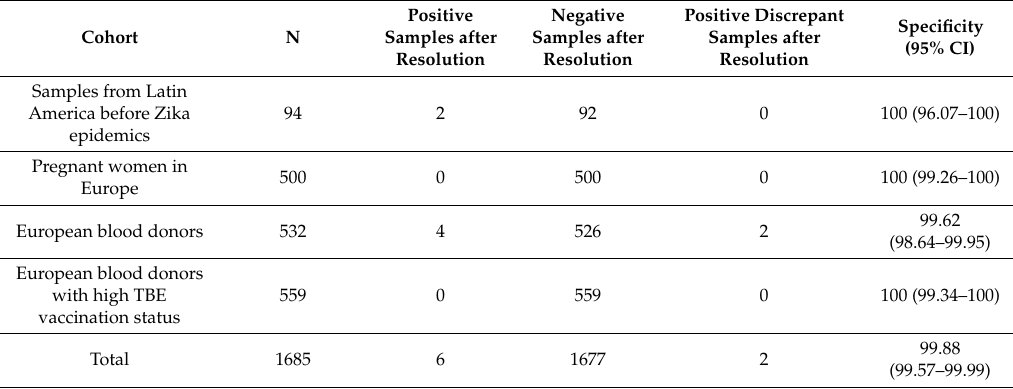
Table 2. Elecsys ® Zika IgG assay diagnostic specificity in samples from non-endemic